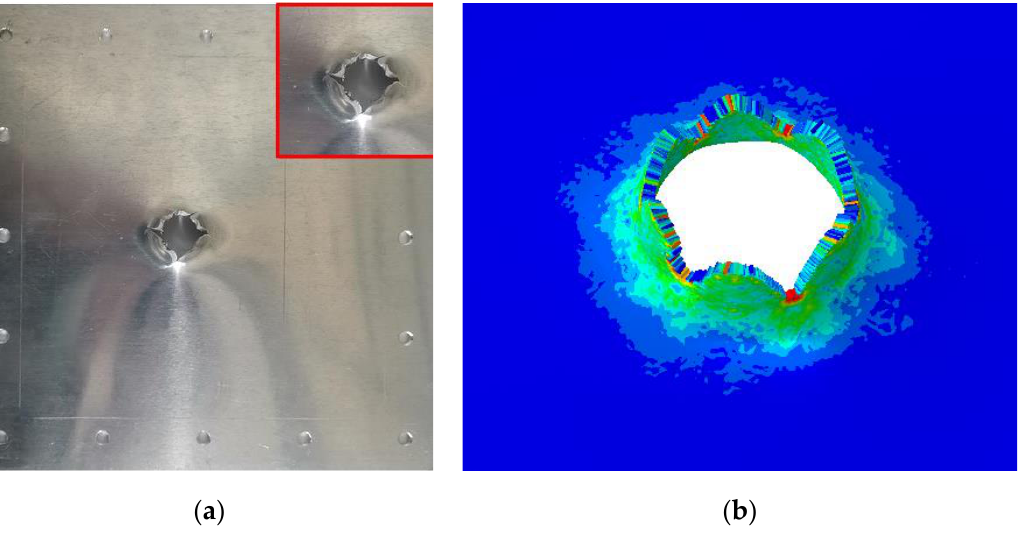
Figure 14. Simulation and experiment comparison: ( a ) experiment results; ( b ) simulation results.